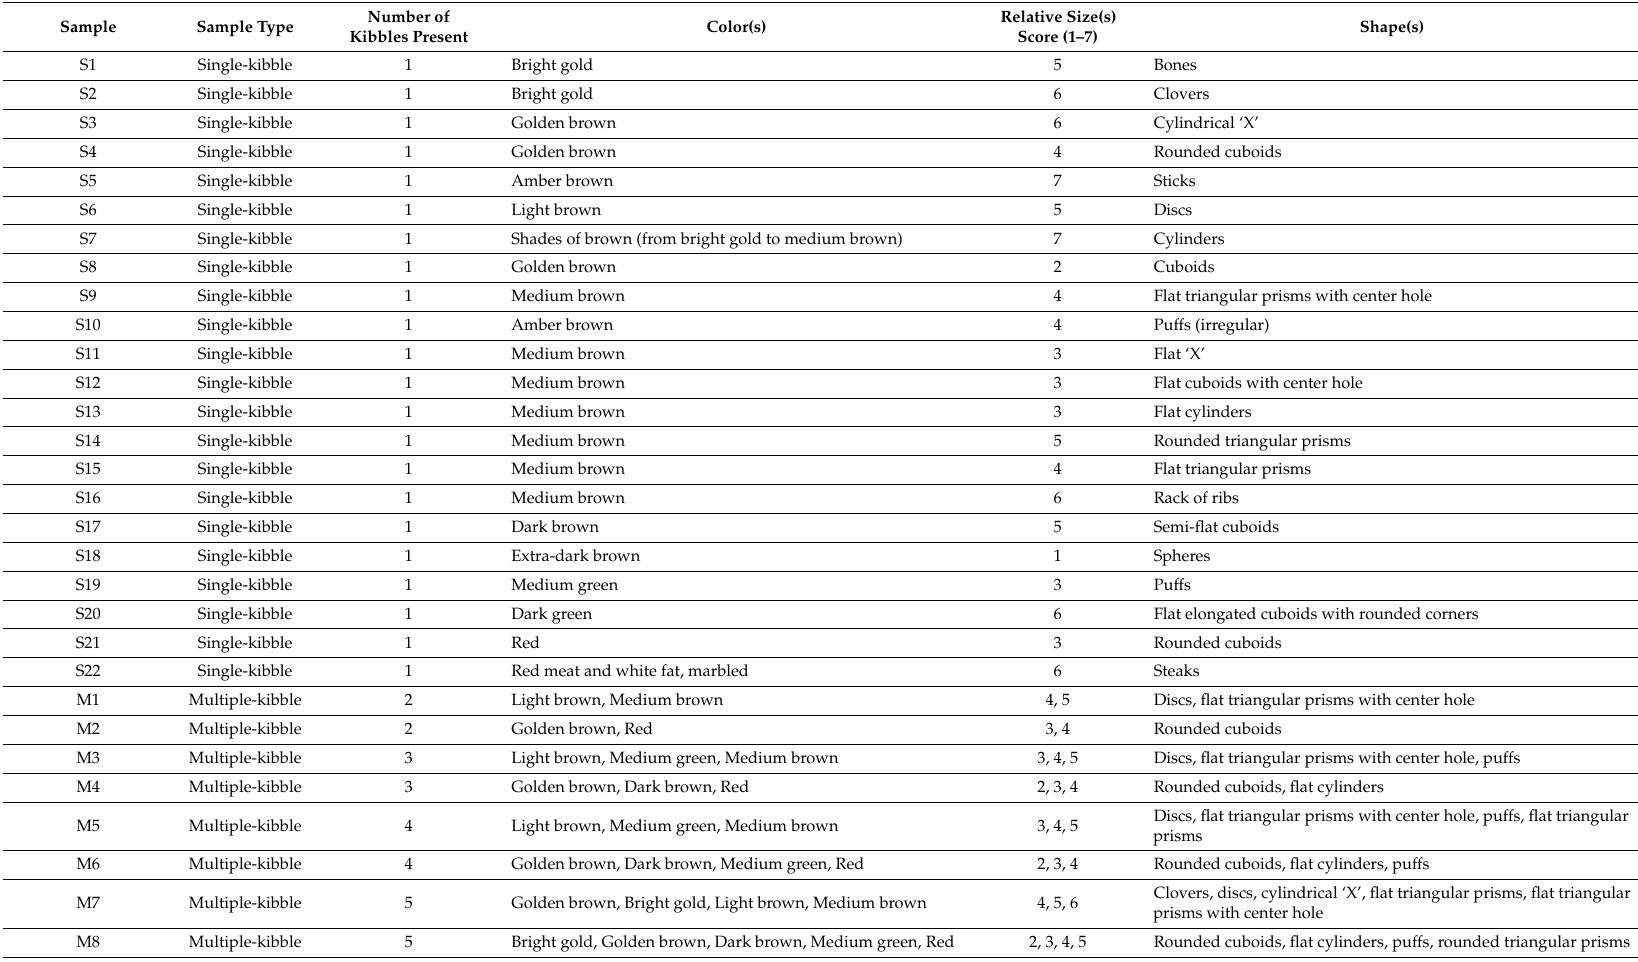
Table 1. Description of the samples (n = 30) used and their visual